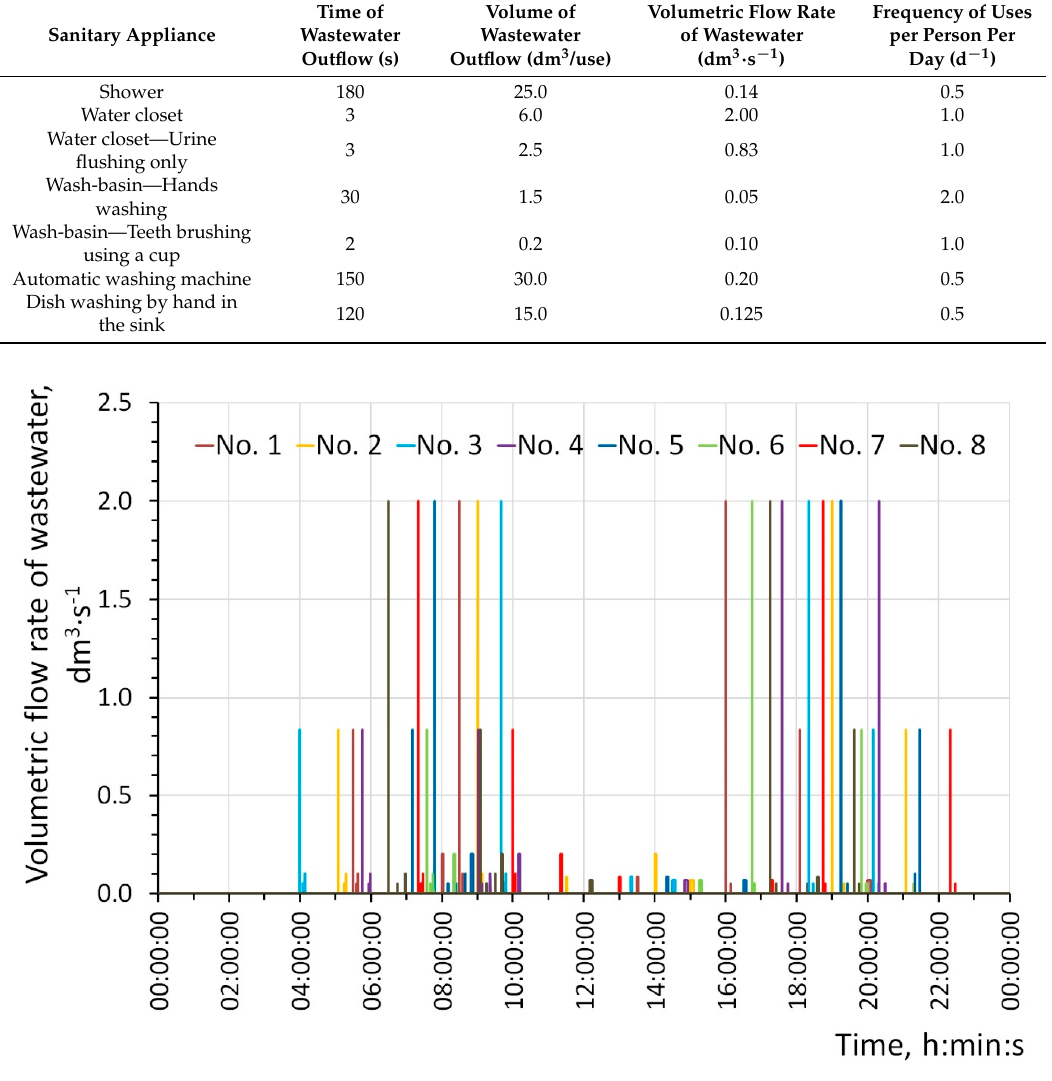
Figure 9. Patterns of raw wastewater inflow to ST during 24 h based on data in Table 2.